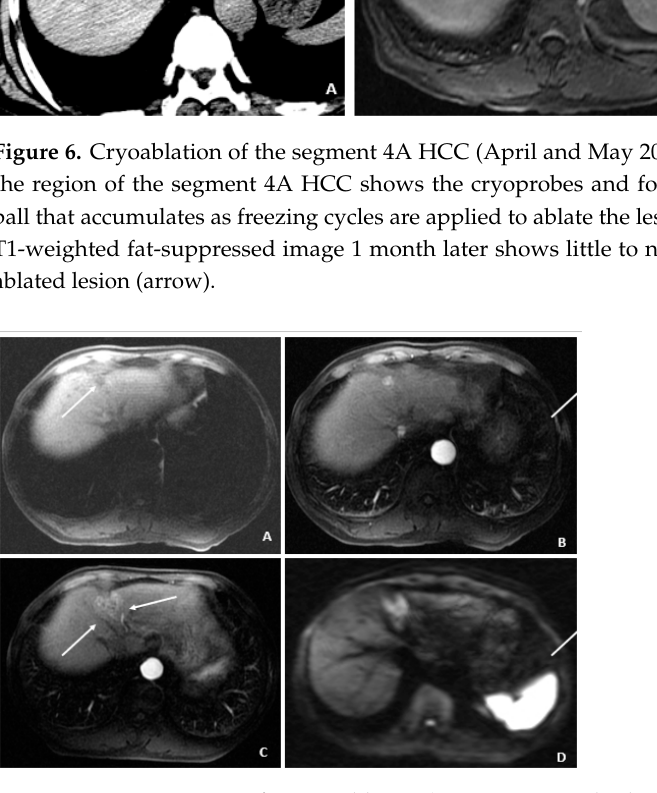
Figure 7. Recurrent HCC after cryoablation (August 2009 and July 2010). ( A ) At 3 months following cryoablation, the axial T1-weighted fat-suppressed precontrast image shows a small hypointense lesion (arrow) above and in proximity to the recently ablated HCC. ( B ) The corresponding arterial- phase postcontrast image shows hyperenhancement (arrow), but additional features (i.e., washout, capsule appearance, etc.) were not observed. ( C ) Months later, a follow-up MRI showed threshold growth of the hyperenhancing lesion (arrows). ( D ) The corresponding diffusion-weighted image shows diffusion restriction (arrows) and helps to confirm the diagnosis of HCC (as an ancillary feature); washout was also evident (not shown), confirming the diagnosis of HCC.